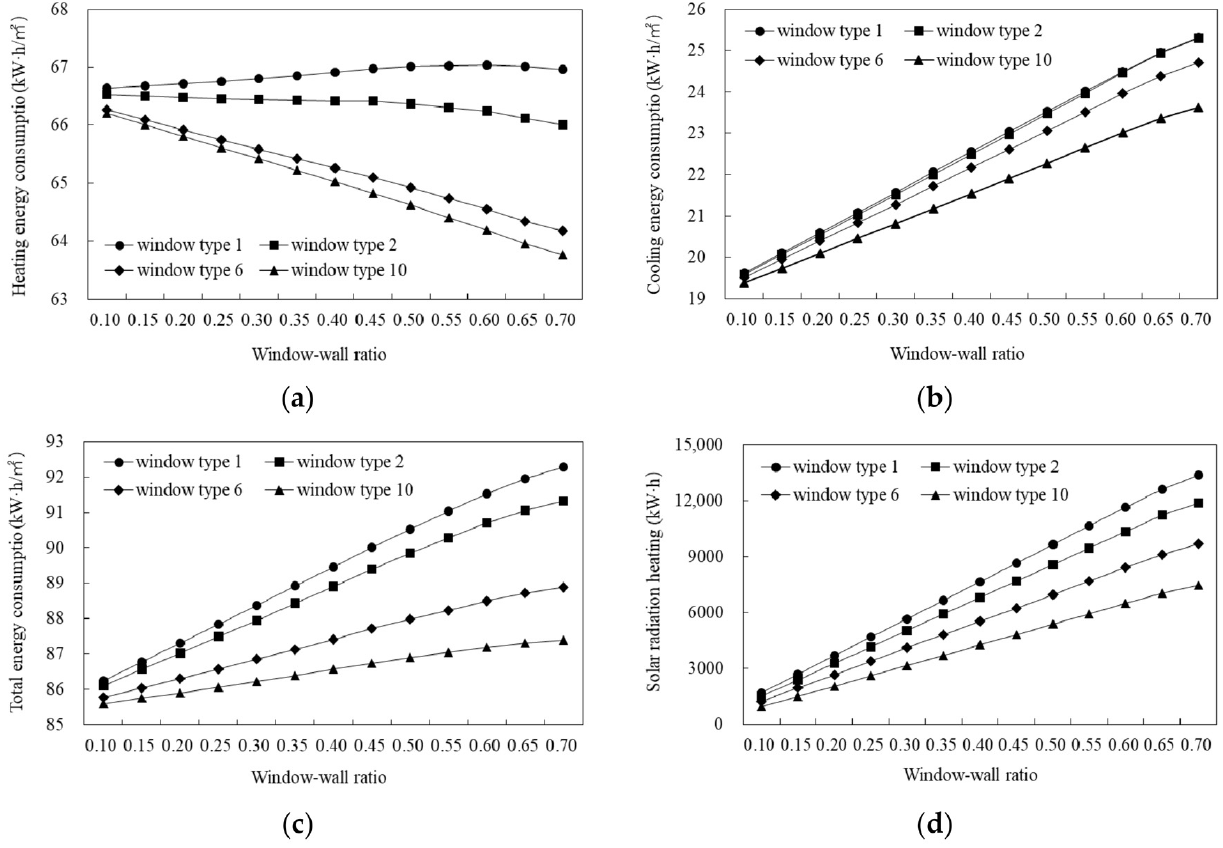
Figure 17. Relationships between north window–wall ratio and energy consumption and solar radiation heating: ( a ) heating energy consumption; ( b ) cooling energy consumption; ( c ) total energy consumption; ( d ) solar radiation